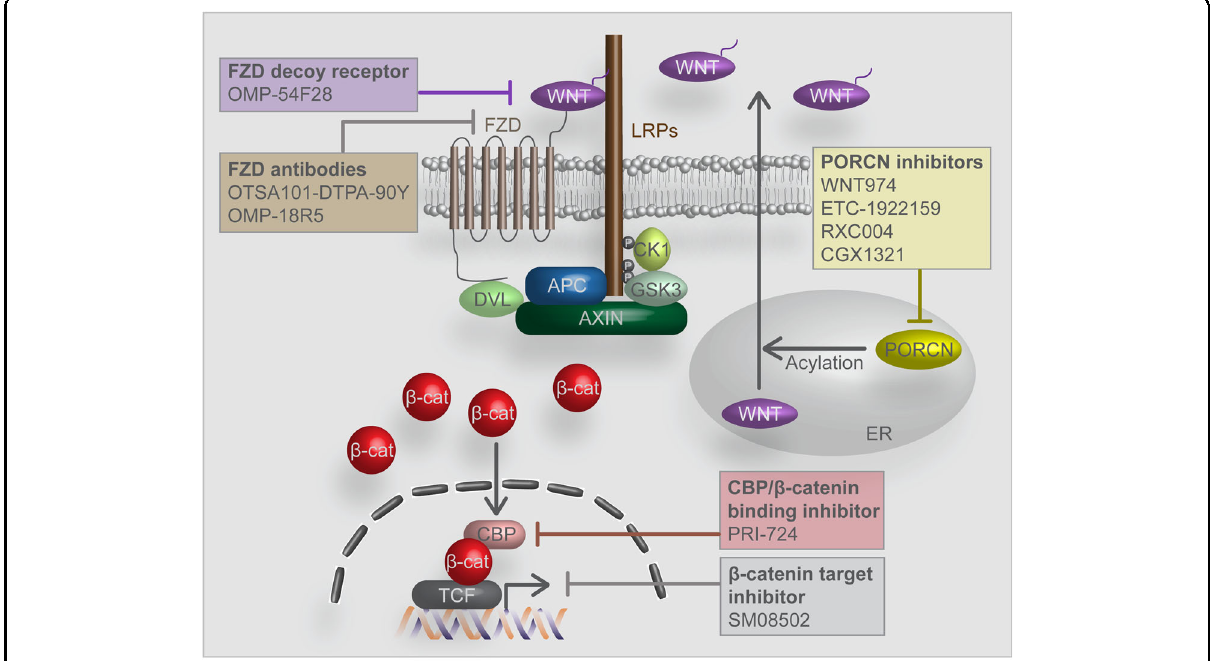
Fig. 1 Wnt/ β -catenin signaling inhibitors in current and past clinical trials (also see Table 1